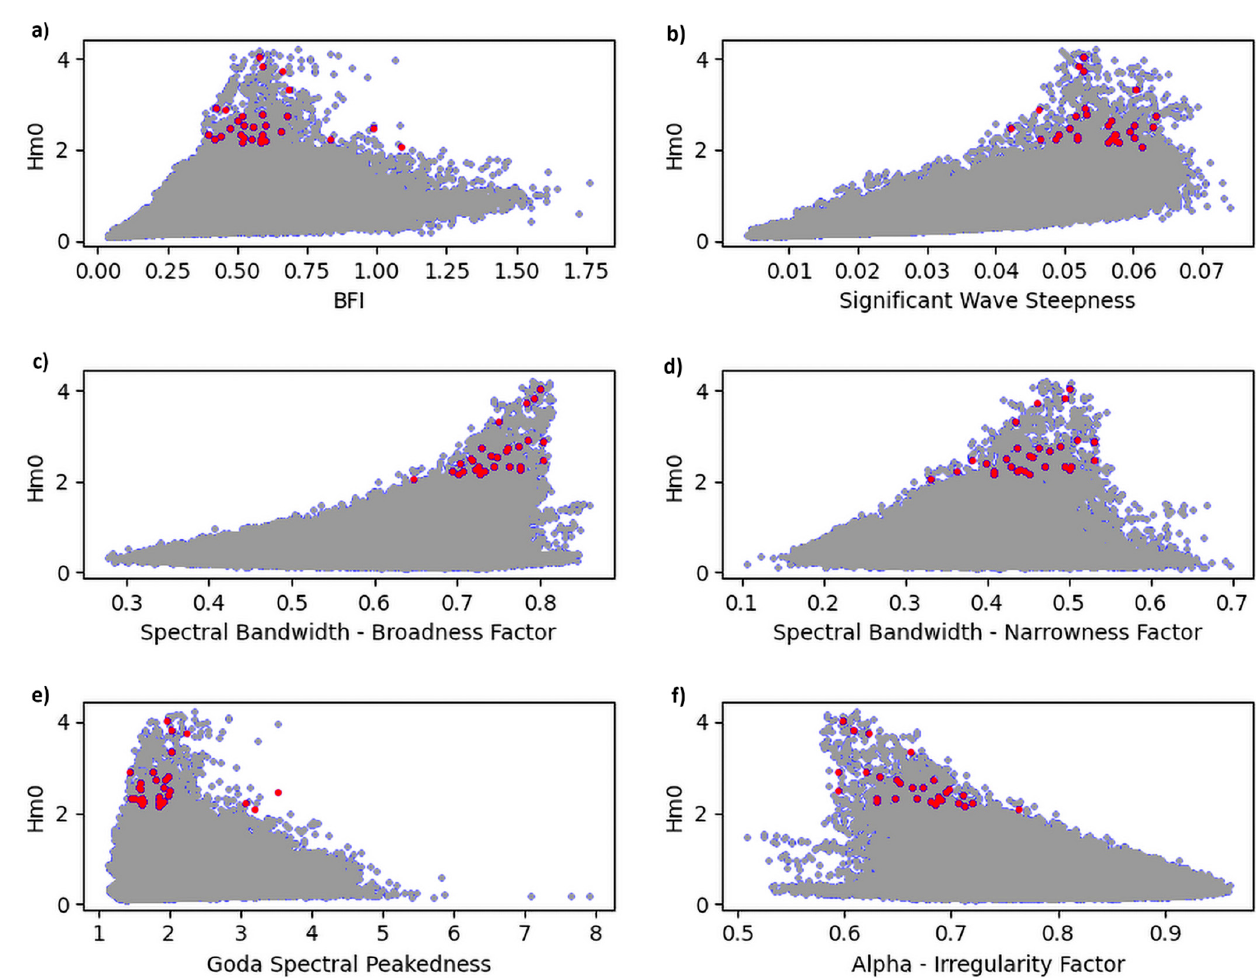
Figure 9. The significant wave height (Hm 0 ) versus BFI ( a ), significant wave steepness ( b ), broadness factor ε ( c ), narrowness factor ν ( d ), Goda’s spectral peakedness Q p ( e ) and irregularity factor α ( f ) of the selected waves. All of the 30-min averaged wave data are shown in blue and the 32 highest wave events are highlighted in red.